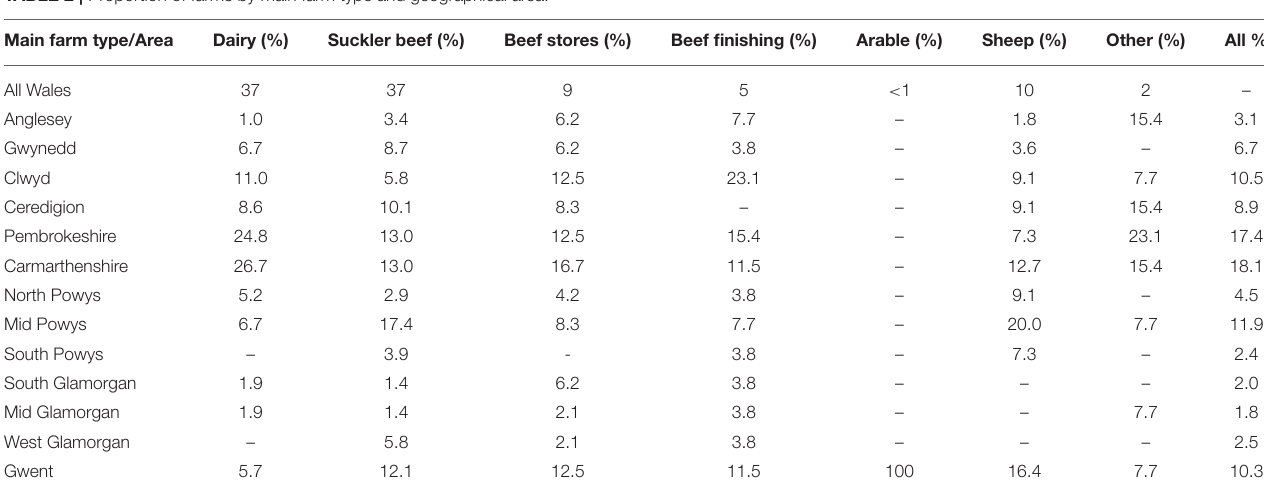
TABLE 2 | Proportion of farms by main farm type and geographical